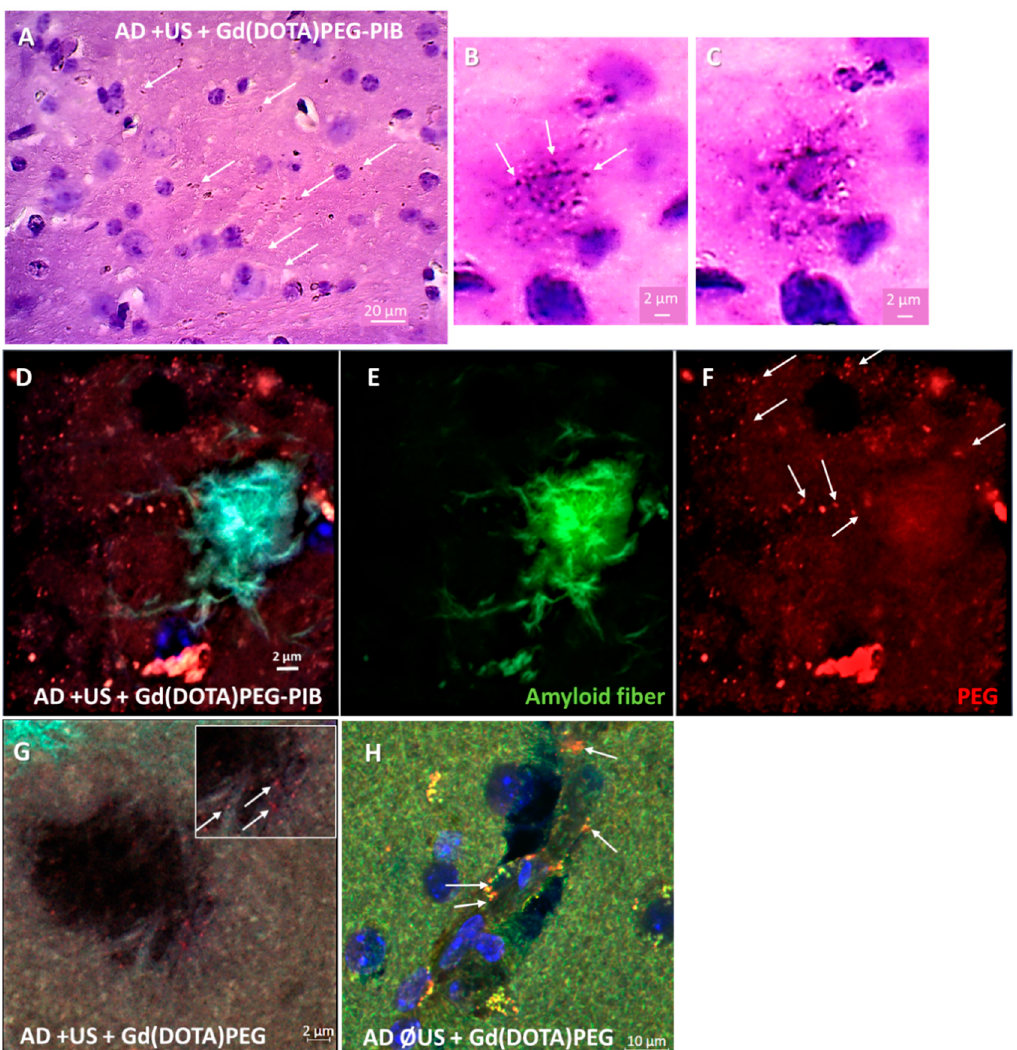
Figure 5. Immunohistological pictures of Gd(DOTA)PEG-PIB delivery inside cerebral tissue after blood–brain barrier (BBB) opening by ultrasound. ( A – C ) The images revealed the diffusion of MNPs into the brain using an antibody directed against the spacer PEG integrated in MNPs (brown spots) ( A ). Some of the Gd(DOTA)PEG-PIB were located in the vicinity of amyloid plaques (hematoxylin–eosin counterstaining) ( B , C ). ( D – F ) Confocal microscopy observations confirmed a close colocalization ( D ) between amyloid fibers (( E ): thioflavin S staining (green)) and Gd(DOTA)PEG-PIB (( F ): anti-PEG antibody revealed by secondary conjugated antibody Alexa-594 (red)). ( G , H ) For control, other AD mice were injected with MNPs without the amyloid-targeting PIB with ( G ) or without ( H ) prior ultrasound opening of the BBB; MNPs diffuse into the brain, but no specific accumulation around amyloid aggregates was observed ( G ), suggesting they remained localized in the vessel ( H ).